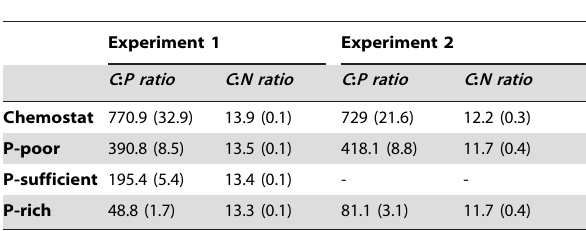
Table 1. Mean (standard error) food quality expressed in molar C:N and C:P ratios for stock cultures (chemostat), P- poor, P-sufficient and P- rich treatments used in the two